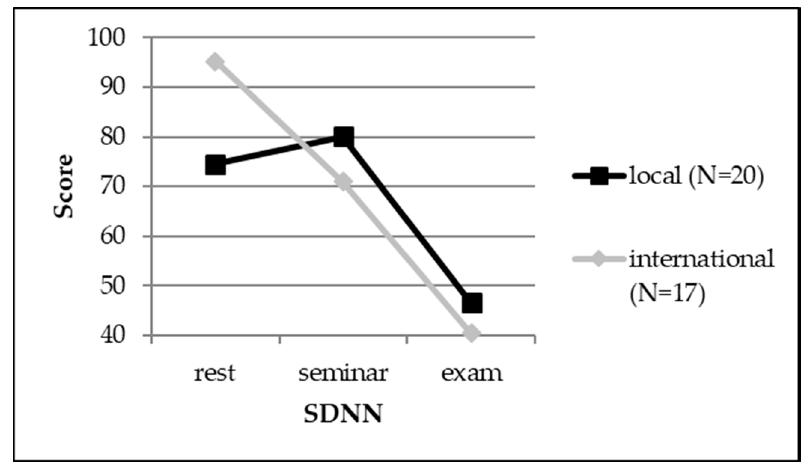
Figure 3. A line chart depicting differences between international and local students concerning the SDNN of heart rate variabilities (HRVs).